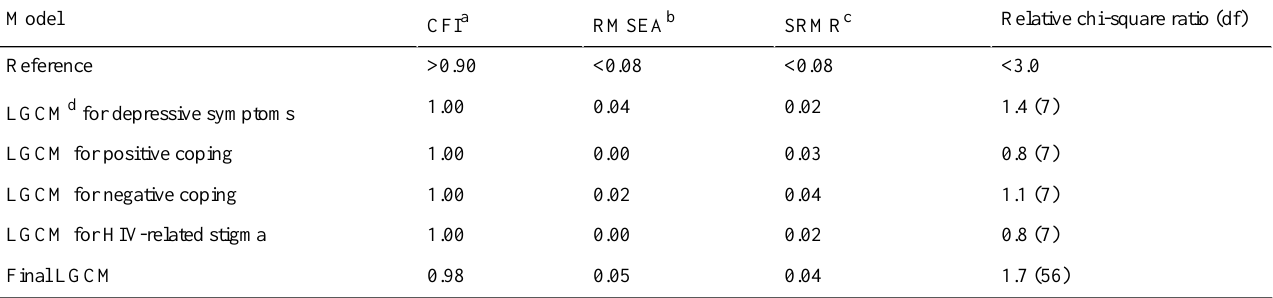
Table 3. Model fit indices of all latent growth curve